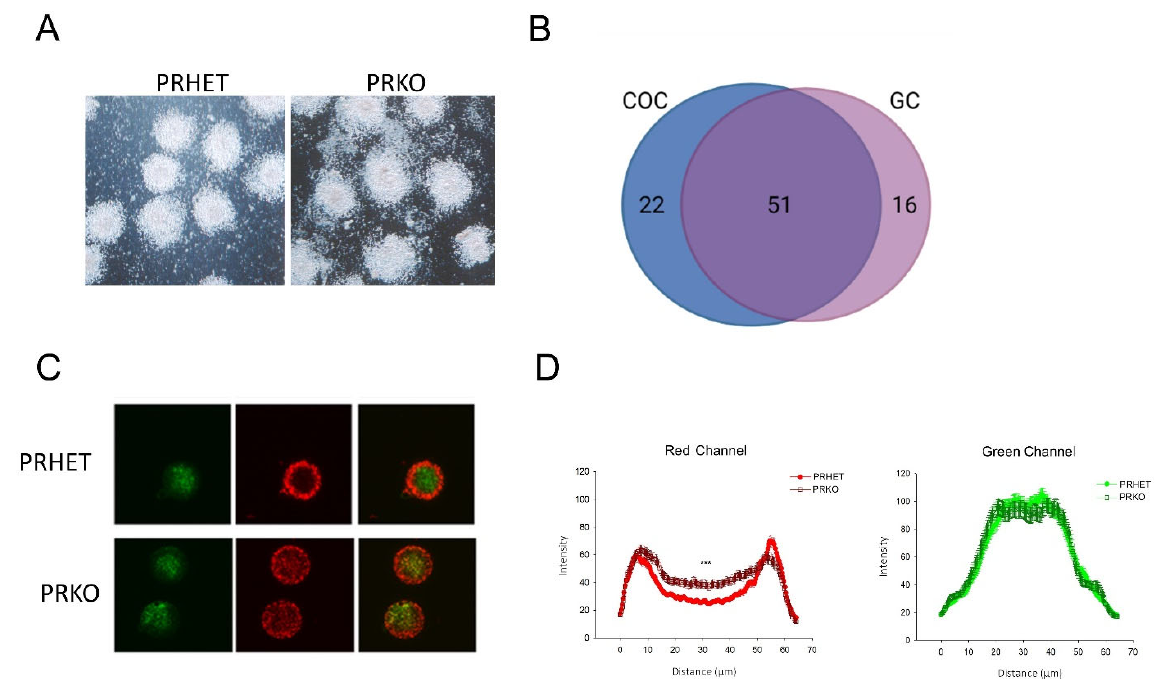
Figure 4. PRKO mice have altered mitochondrial distribution and changes in cumulus cell gene expression. ( A ) COCs collected from antral follicles of PRKO and heterozygous controls at 10 h post-hCG and photomicrograph images captured. ( B ) Microarray analysis was performed on COCs at 8 h post-hCG and PRKO differentially expressed genes (DEGs) identified (logFC ≥ 1, padj ≤ 0.01). COC DEGs were compared to previous microarray data of DEGs in the granulosa cells (GCs). ( C ) Denuded oocytes from PRKO and heterozygous controls were stained with JC-1 potentiometric dye to determine high mitochondrial membrane potential (red) and low mitochondrial potential (green). ( D ) JC-1 red channel and green channel fluorescence intensity and distribution were analyzed across the oocyte midsection. n = 4 mice per genotype, with an analysis of 58–61 oocytes. Statistical significance between genotypes was determined by mixed-model two-way ANOVA, *** p <